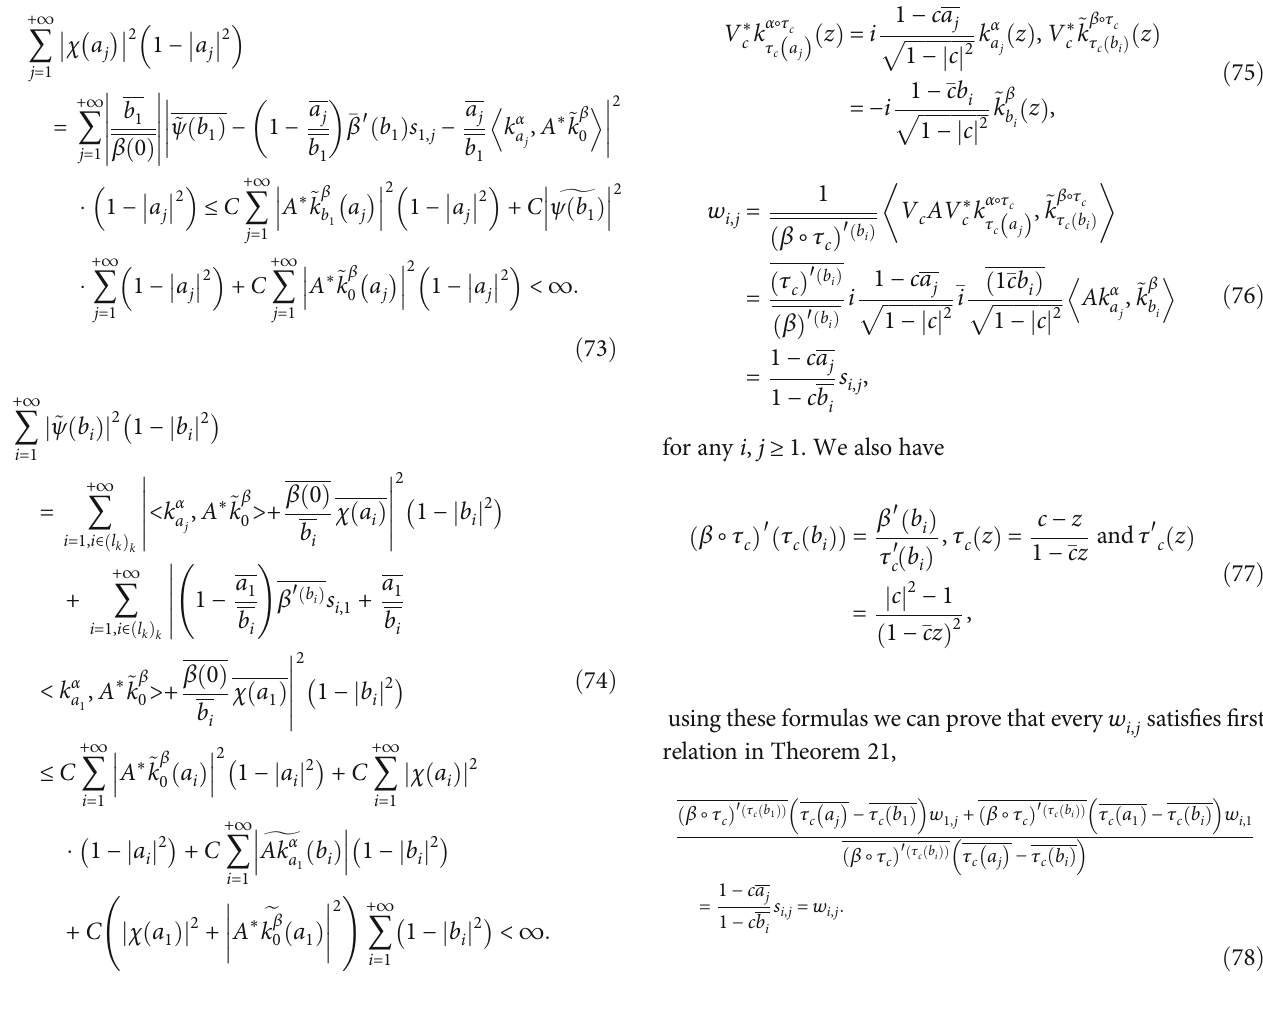
ffiffiffiffiffiffiffiffiffiffiffiffiffiffi p 1 − c j j 2